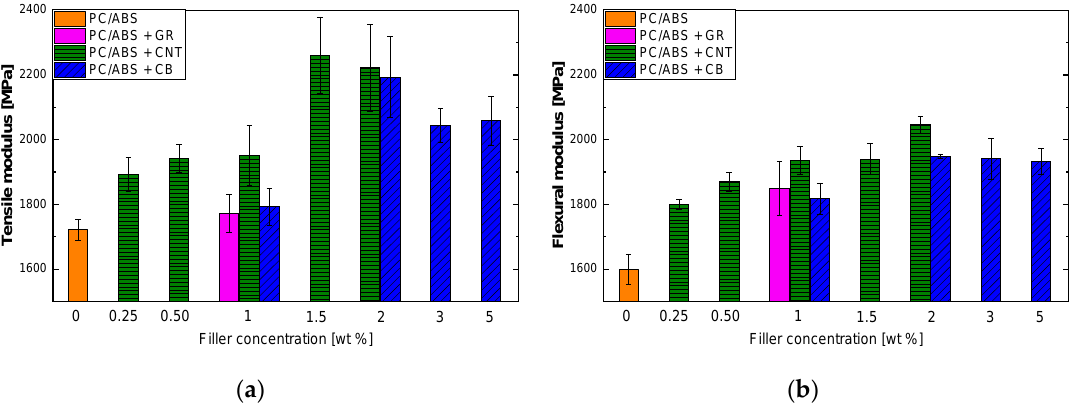
Figure 7. Elastic moduli of composites obtained by melt blending at different concentrations of filler: ( a ) tensile modulus; ( b ) flexural modulus.